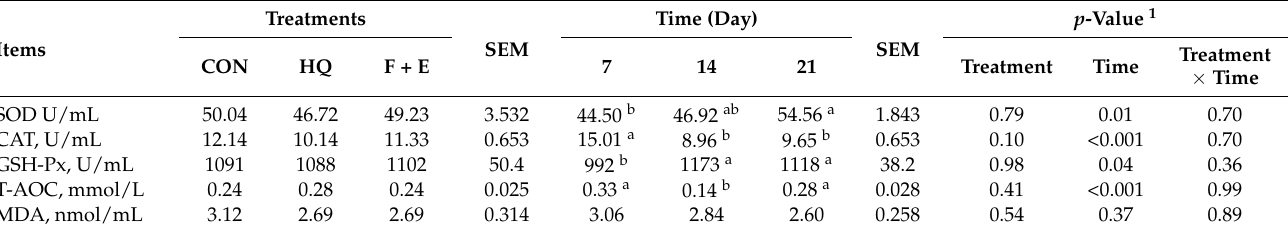
Table 5. Serum antioxidant capacity of lactating sows.